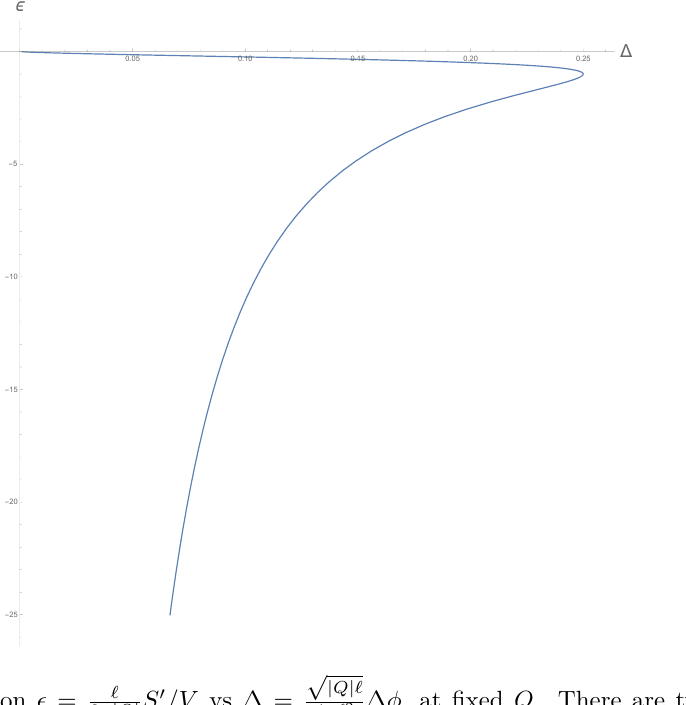
√ | Q | ‘ S 0 /V vs ∆ = ∆ φ , at fixed Q . There are two solitons for 2 π | Q | 4 π‘ 2